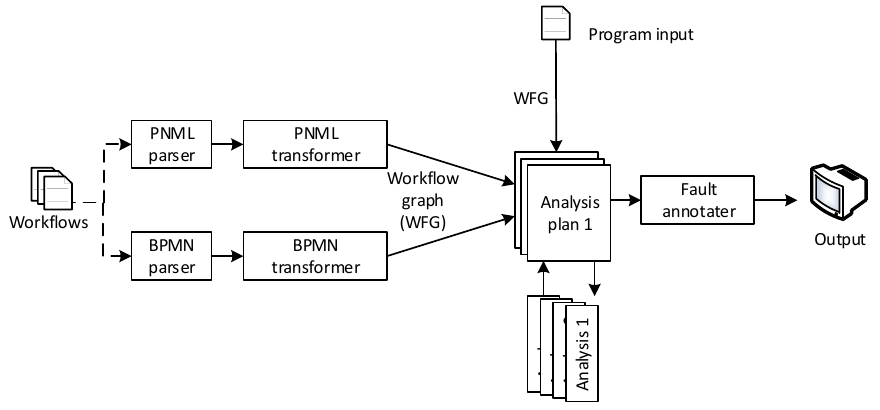
Figure 22. Conceptual architecture of